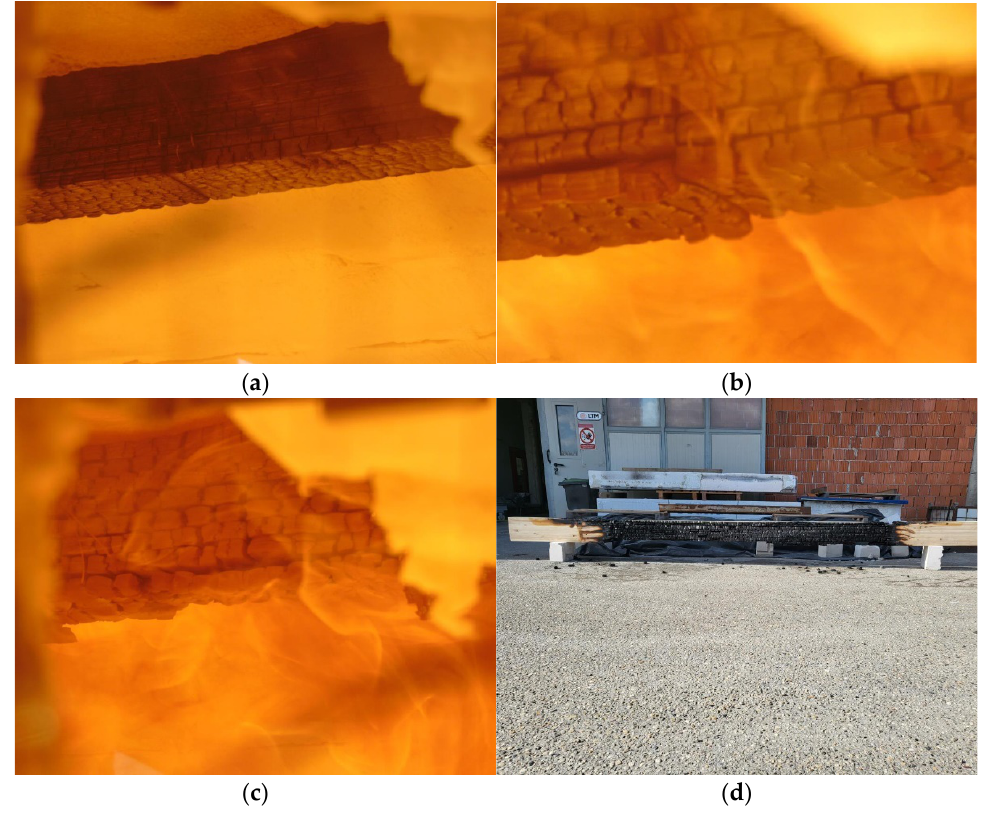
Figure 15. Normal beam—phases of the fire test: ( a ) 5 min; ( b ) 20 min; ( c ) 40 min; ( d ) the end of the test.